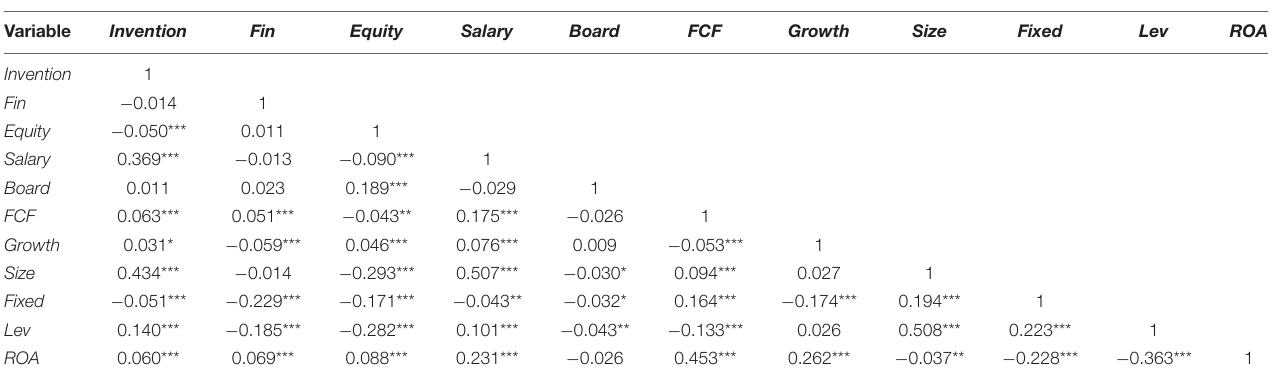
TABLE 3 | Pearson-correlation